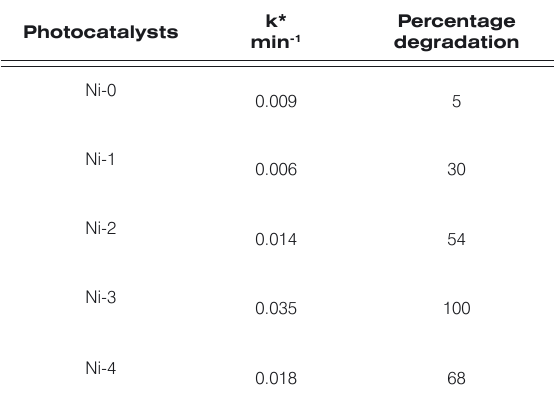
* First order rate constant is calculated from the plot of –log C/C time.